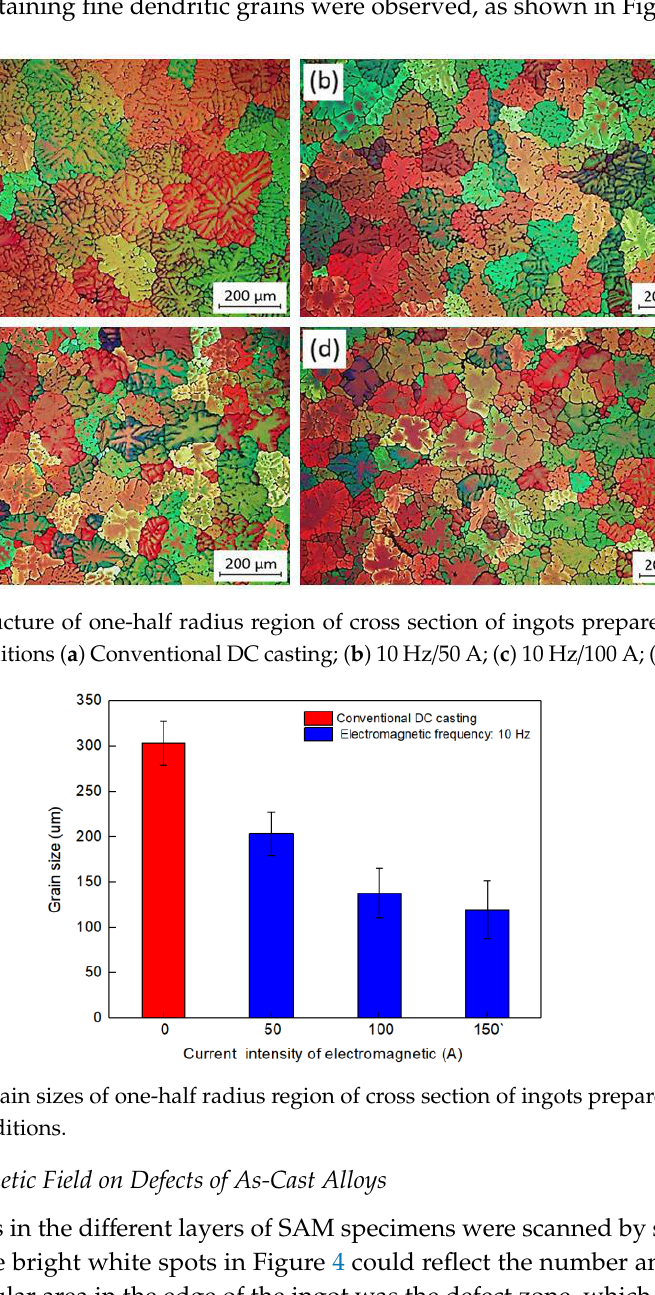
Figure 3. Average grain sizes of one-half radius region of cross section of ingots prepared in different electromagnetic conditions.